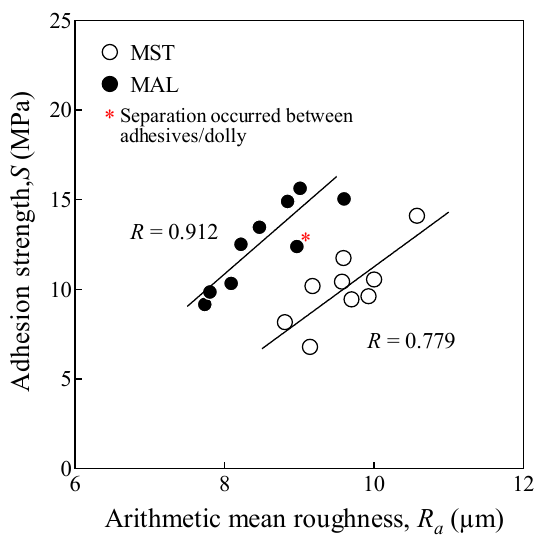
Figure 6. Fracture surface of the unpainted steel after the adhesion test (MAL, Blasting angle 90°).